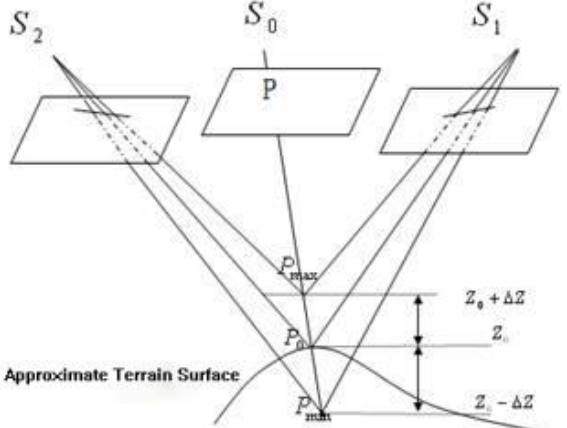
Figure 1 Correlation Coefficient with Geometric Constraint